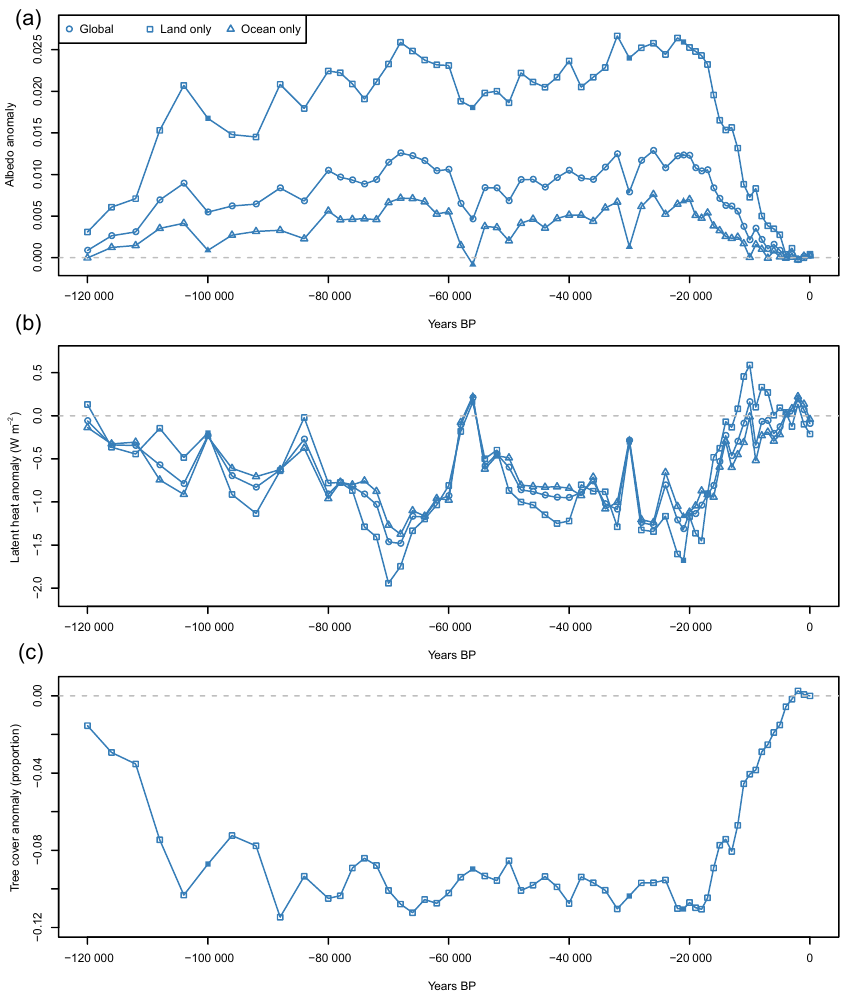
Figure 4. Mean annual anomaly Dynamic–Static simulations for (a) surface albedo, (b) latent heat (Wm − 2 ), and (c) tree cover (proportion of land